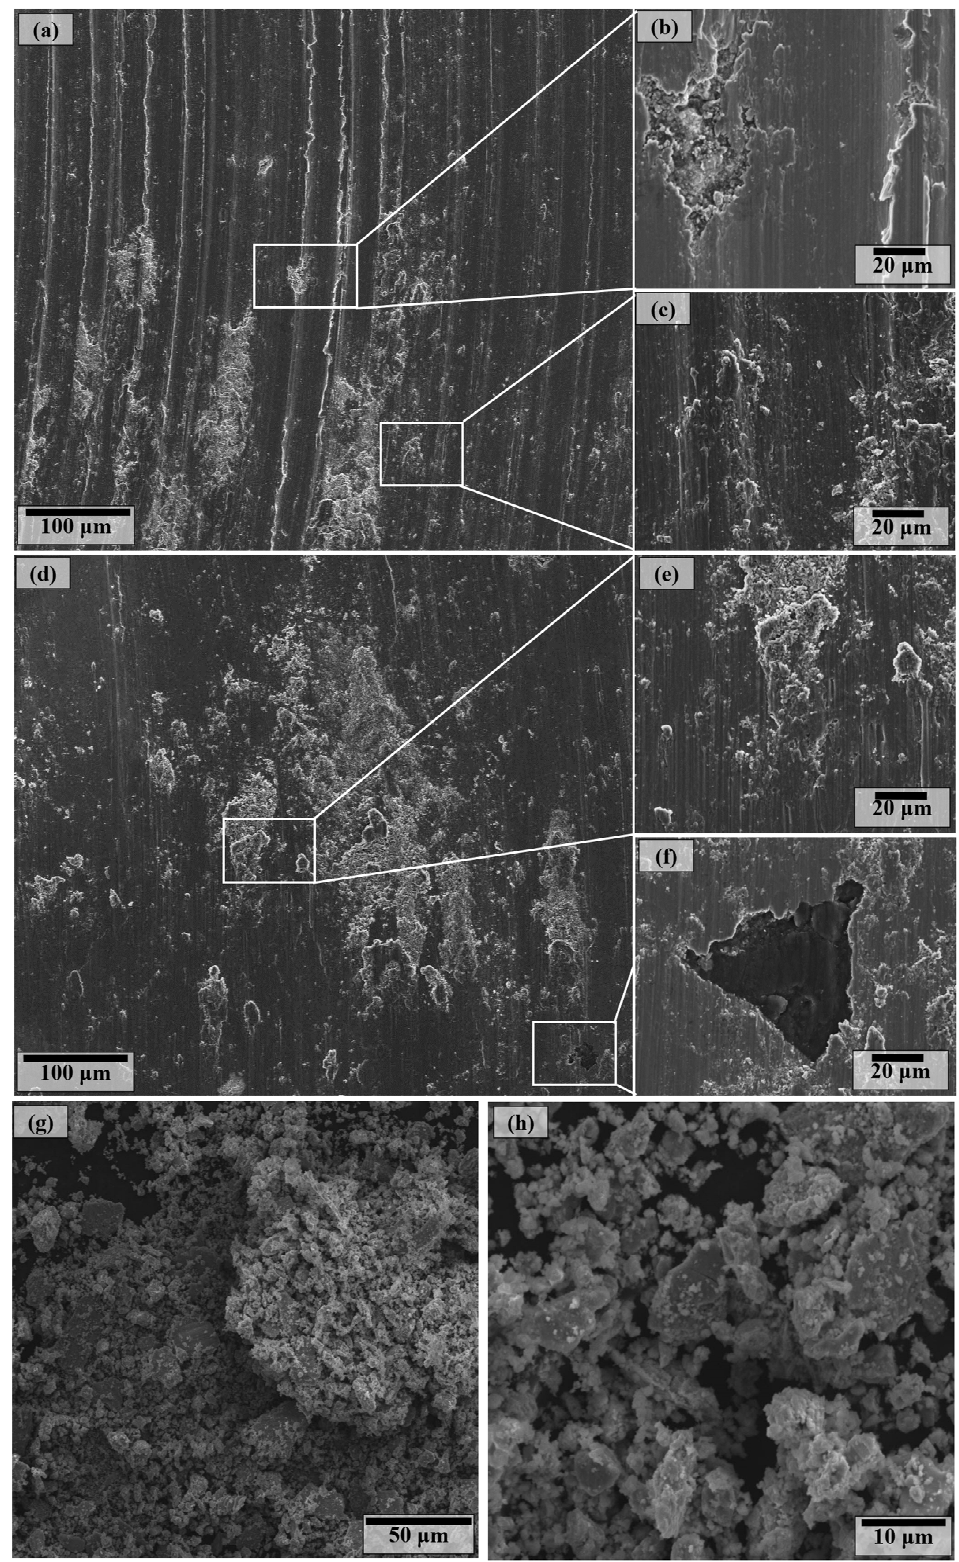
Figure 11. Post-test SEM of worn unpeened surface at sliding distance of 600 m at low magnification ( a ) and at high magnification ( b , c ); worn shot-peened surface at a sliding distance of 600 m at low magnification ( d ) and at high magnification ( e , f ); SEM images of wear debris particles ( g , h ).